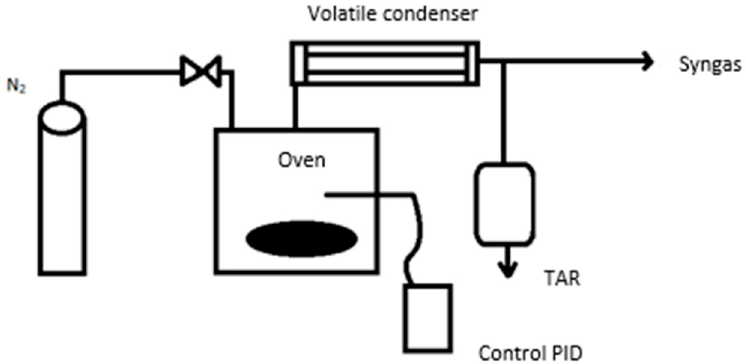
Figure 1. Schematic diagram of pyrolysis.